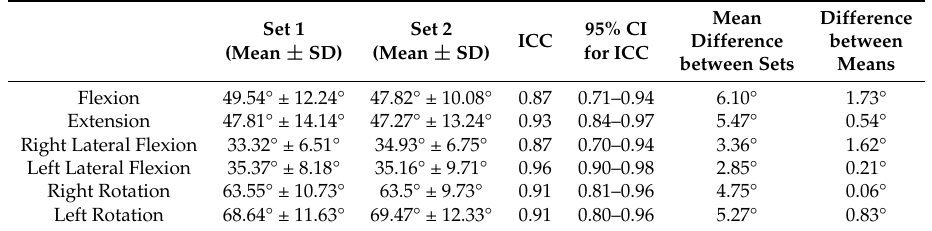
Table 1. Results for the two sets of motions performed with the second sensor located in C7 considering half movements.